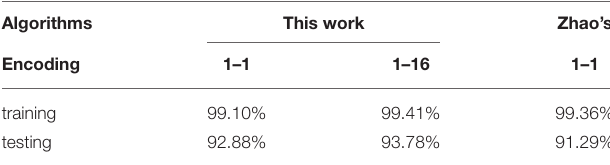
5 TABLE 2 | Accuracy of single orientation object = ×